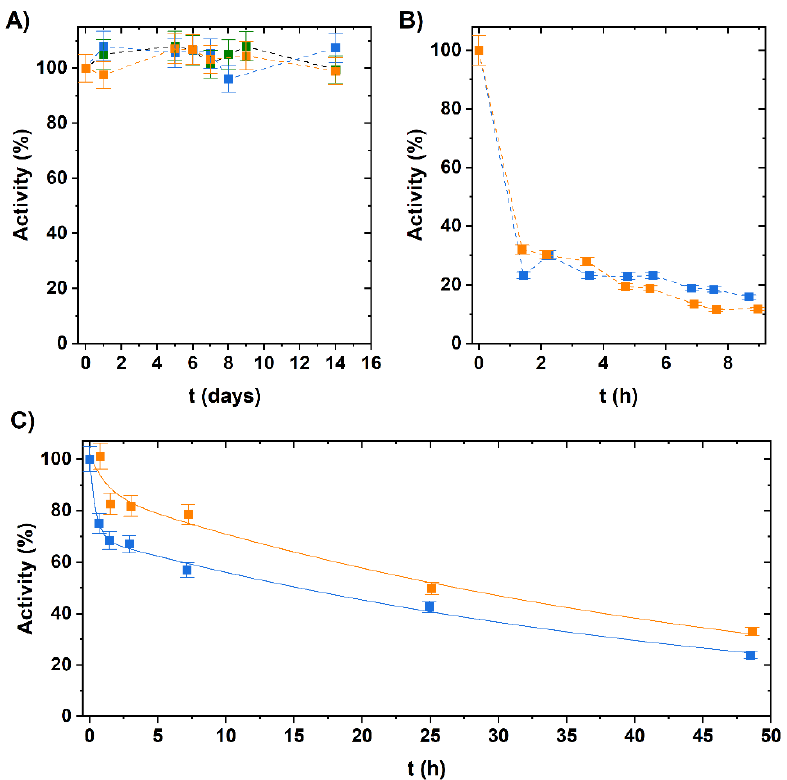
Figure 2. Time course of activity of different enzyme catalysts incubated under resting conditions. Free enzyme (green) and immobilized enzyme: Ag ‐ PEI 2000 U _pNPG /g support (orange) and Ag ‐ Gly 2000 U _pNPG /g support (blue). ( A ) T = 50 °C, ( B ) T = 70 °C and ( C ) T = 65 °C. The data shown are representative of the multiple time ‐ course experiments repeated. Continuous line in Panel ( C ) is the line of the biexponential fitting, showing a biphasic inactivation.